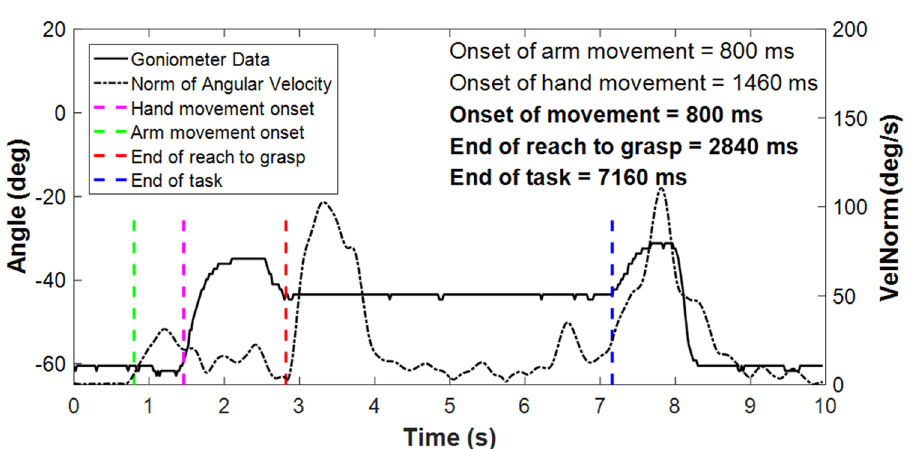
Figure 6. Example data and the timestamps identified by the algorithms. This example shows a smooth completion of the task. The bold solid line shows the angle data recorded by the goniometer worn across the proximal knuckle of the index finger, the dashed line shows the norm of the angular velocity recorded from the IMU worn on the wrist. The coloured vertical lines show the automatically detected segmentation points. The onset of arm movement is shown in green, the onset of hand opening is highlighted in magenta, the end of reach to grasp is shown in red, and task completion in